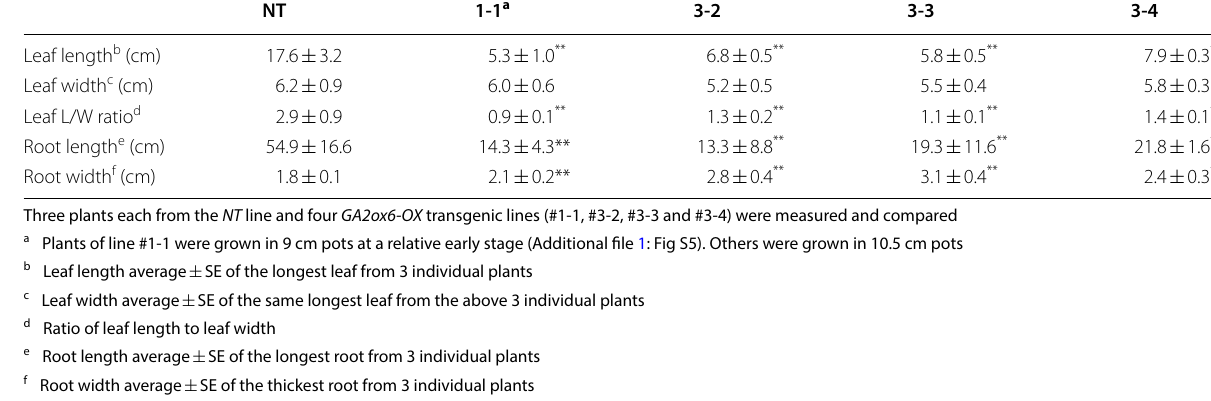
Table 1 Morphological comparison of leaves and roots in nontransgenic ( NT ) and GA2ox6-OX transgenic lines